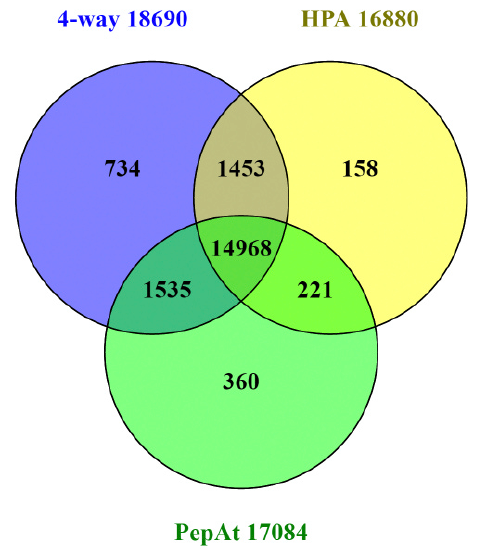
Figure 5. Swiss-Prot cross-reference intersects between the 4-way confirmed set from Figure 3, the Human Protein Atlas (HPA), and the Peptide